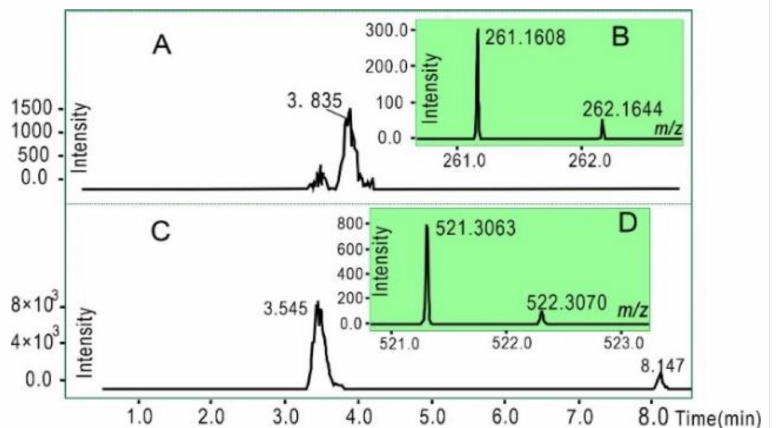
Figure 4. UHPLC–ESI-Q-TOF-MS analysis of Fer-1 with 16-DOXYL-stearic acid free radical: ( A ) chro- matographic profile of standard Fer-1; ( B ) MS spectrum of standard Fer-1 (Rt = 3.835 min); ( C ) MS spectrum of Fer-1 dimer; ( D ) MS spectrum of Fer-1 dimer (Rt = 3.545 min). The ESI was run in negative ionization mode.